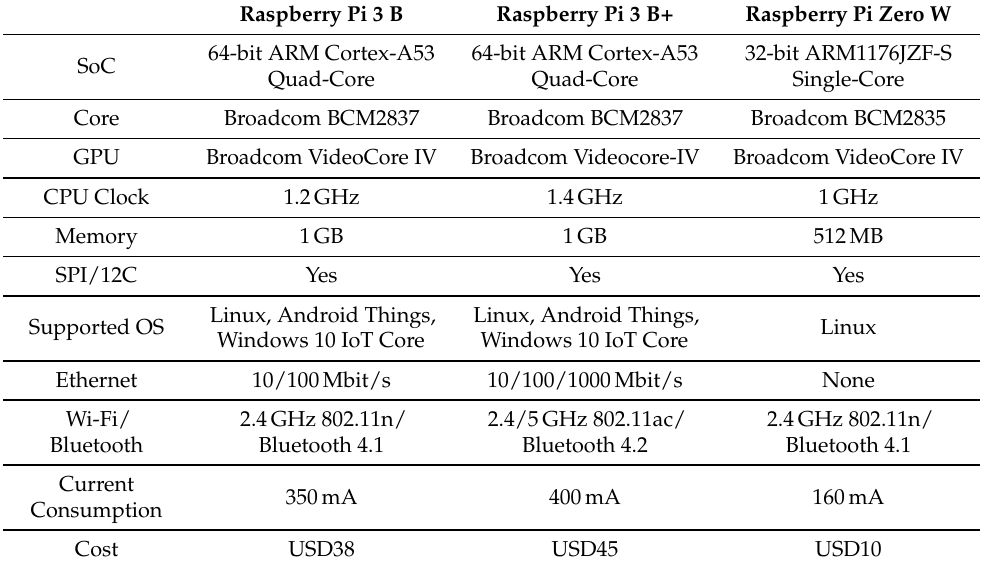
Table 4. Main characteristics of the tested smart gateway